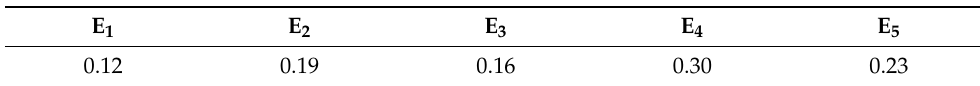
Table 10. Experts’